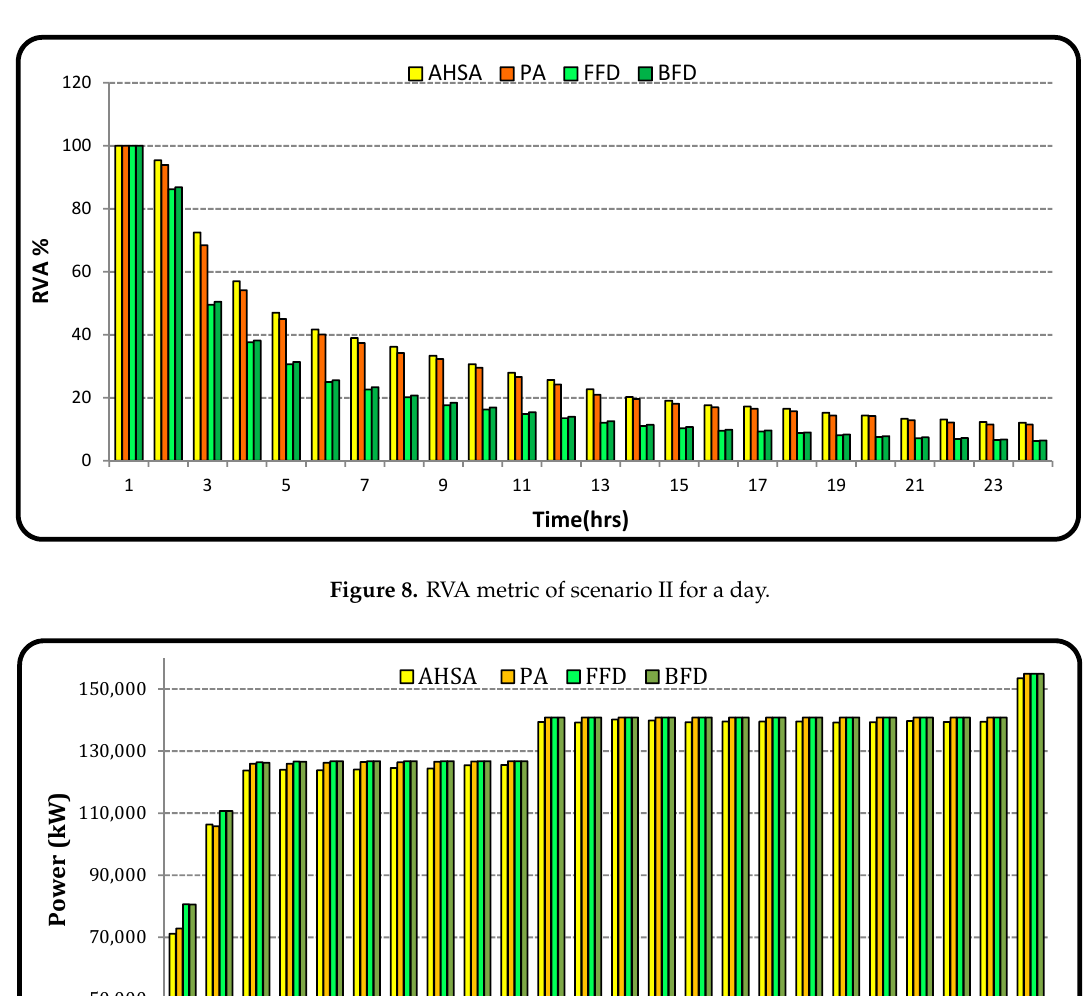
Figure 10. CPU utilization of scenario II for 100% RVA for first 14 cycles.